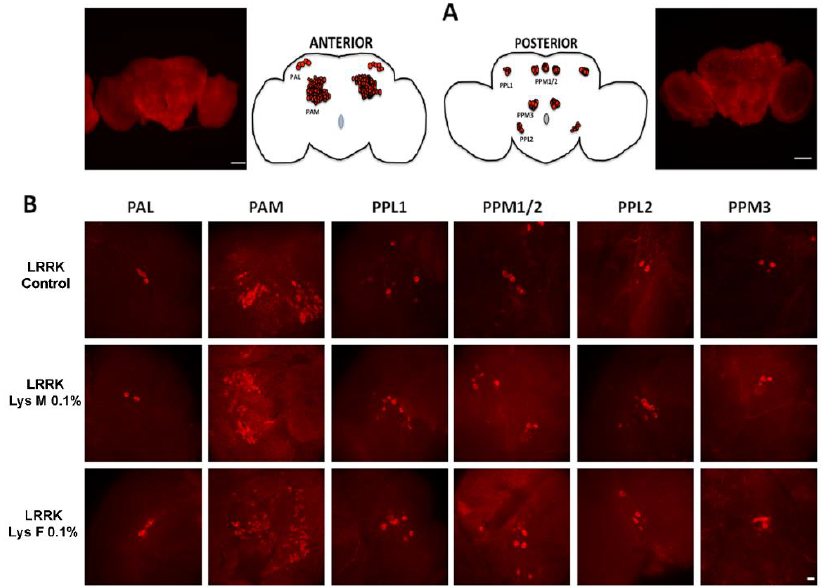
Figure 5. Anterior and posterior dopaminergic (DA) clusters in LRRK flies. A = micrograph (10×) and schematic representation of brain anterior and posterior faces where the DA clusters reside. B = representative image stacks (63×) showing the distribution of dopaminergic neurons in the different clusters in LRRK control and mDLE (LysM) and fDLE (LysF)-treated groups. The bars represent 100 (Panel A) and 10 µm (Panel B).